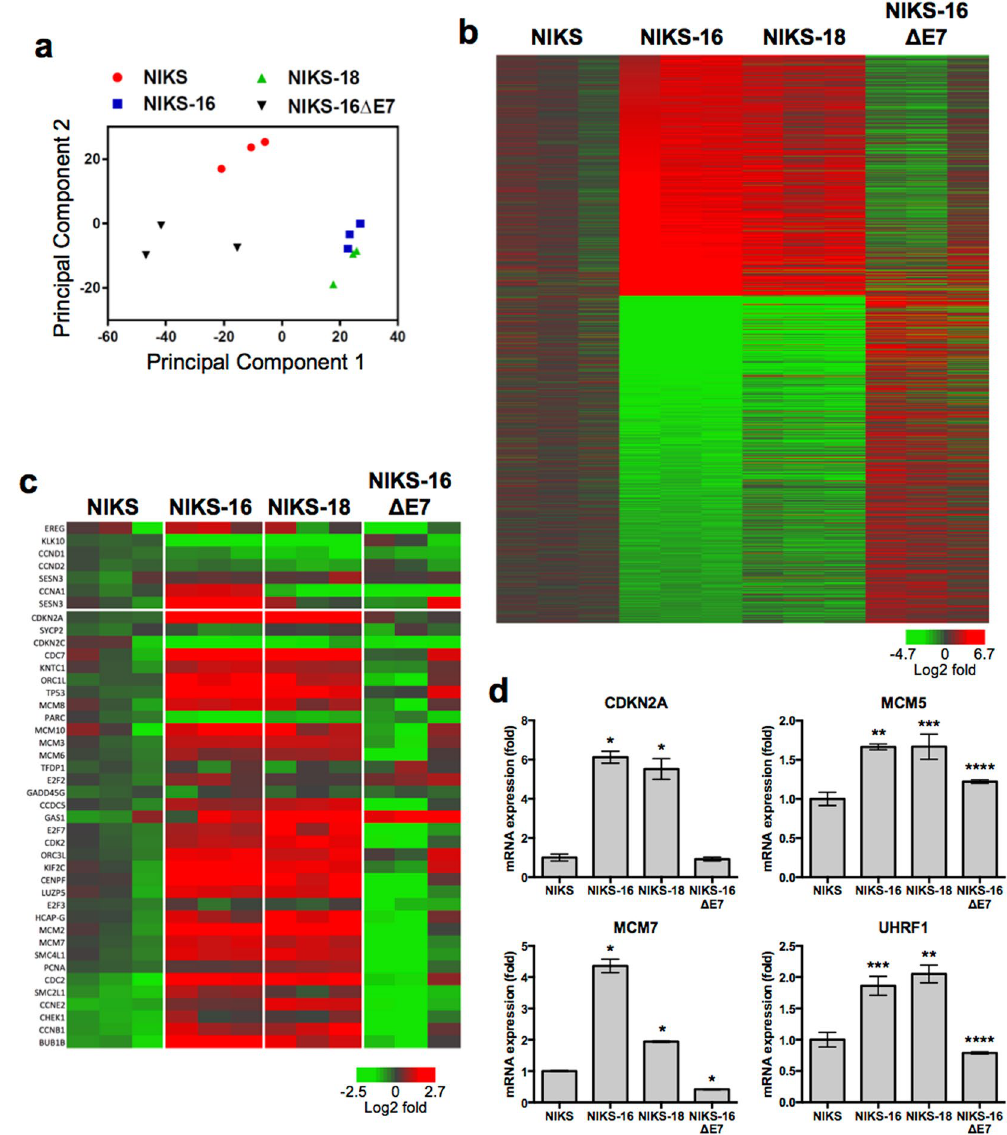
Figure 1. High-risk HPV E7 distinctly alters host gene expression in keratinocytes. Gene expression profiles were assessed by Affymetrix Human Genome U133 Plus 2.0 arrays in triplicate for keratinocytes lines, NIKS, NIKS-16, NIKS-18, and NIKS-16 Δ E7, in three different passages. ( a ) Principal component analysis data are shown for each of three replicates of NIKS (red circle), NIKS-16 (blue square), NIKS-18 (green triangle) and NIKS-16 Δ E7 (black triangle) cells. ( b ) Log2 fold changes of differentially expressed genes in both NIKS- 16 vs. NIKS cells and NIKS-16 vs. NIKS-16 Δ E7 cells are shown by heat map (FDR adjusted p < 0.05 and a change > 30% magnitude in expression). Probe IDs are listed in Table S1. ( c ) Heat map presents log2 fold changes (NIKS-16 vs. NIKS cells and NIKS-16 vs. NIKS-16 Δ E7 cells) of dysregulated cell cycle-related genes previously identified in HNC and CxCa patient tissue samples 17 . ( d ) CDKN2A, MCM5, MCM7 , and UHRF1 expression levels were determined by RT-qPCR and normalized to β -actin expression levels. Each sample was quadruplicated, and shown are representative of three repeats. Fold changes compared to NIKS cells are plotted. P -values were calculated by Student’s t test. * p < 0.0001, ** p < 0.001, *** p < 0.01, **** p <